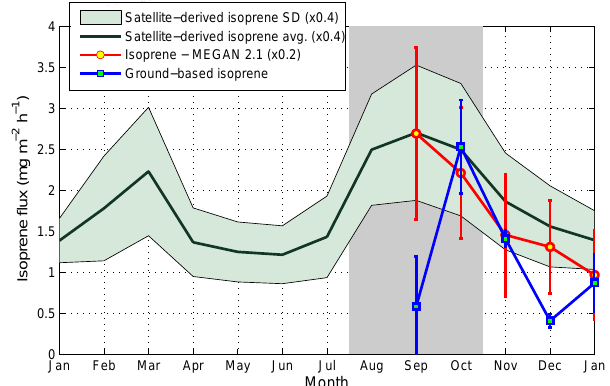
Figure 7. Comparison of monthly isoprene emissions based on in- situ PTR-MS measurements (inverse Lagrangian transport model) and satellite-derived estimates and MEGAN 2.1 estimates. Satellite- derived estimates are from January 2010 to January 2011, and ground-based estimates are from September 2010 to January 2011. Satellite-derived and MEGAN 2.1 estimates were divided by 2.5 and 5, respectively. Grey area represents the period of the dry sea- son. Error bars represent 1 standard